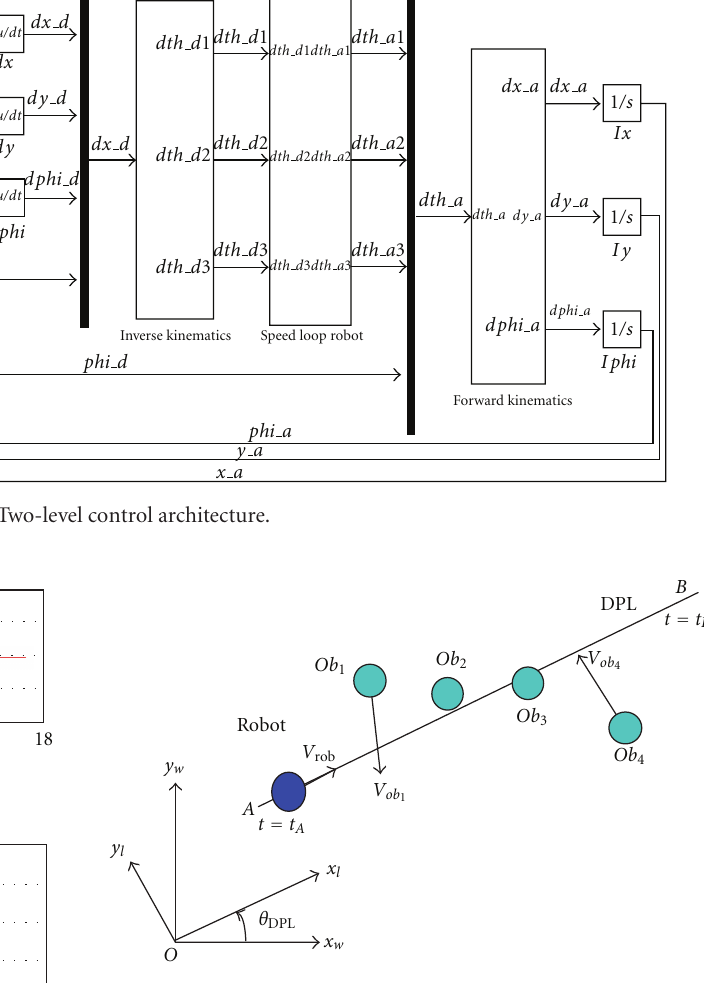
Figure 5: Mobile robot in dynamic environment with moving